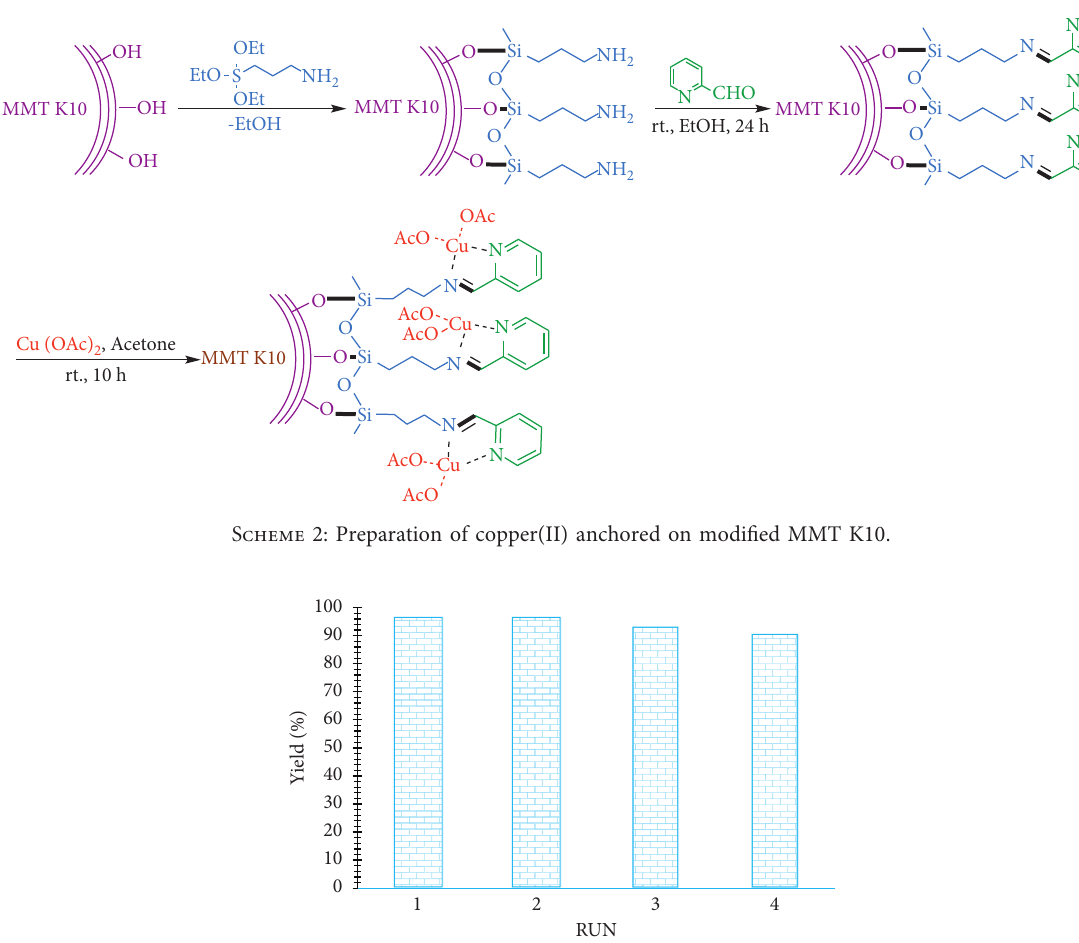
� CHPy]-Cu(II) for the model reaction. 2 ) 3 -NH